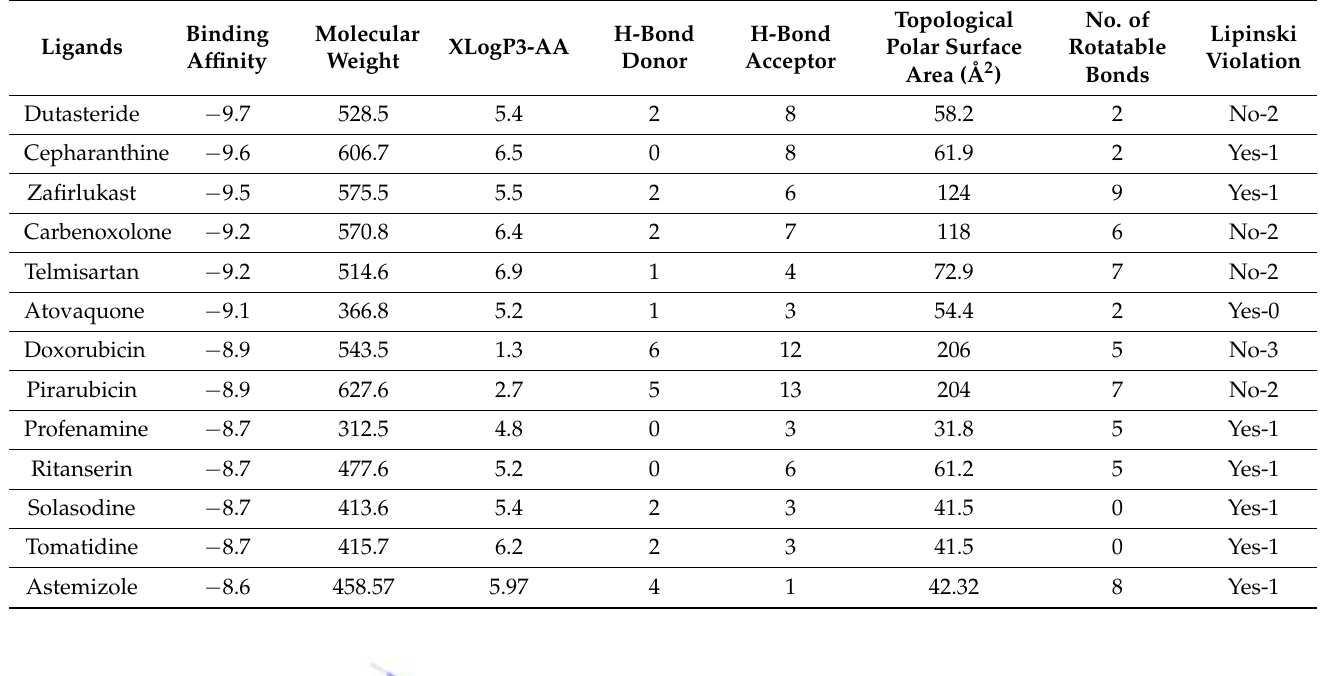
Table 1. Table representing the top 5% drugs selected after docking (on the basis of binding affinities) and ADME toxicity analysis.